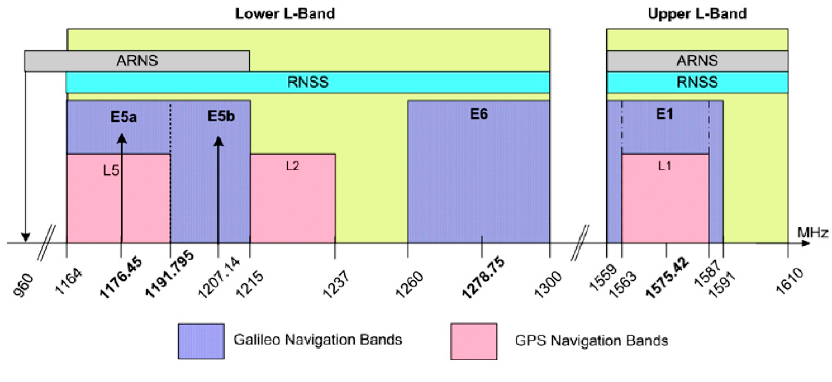
Figure 3. Galileo frequency plan [47]. Table 1. Galileo carrier frequency per signal [47].